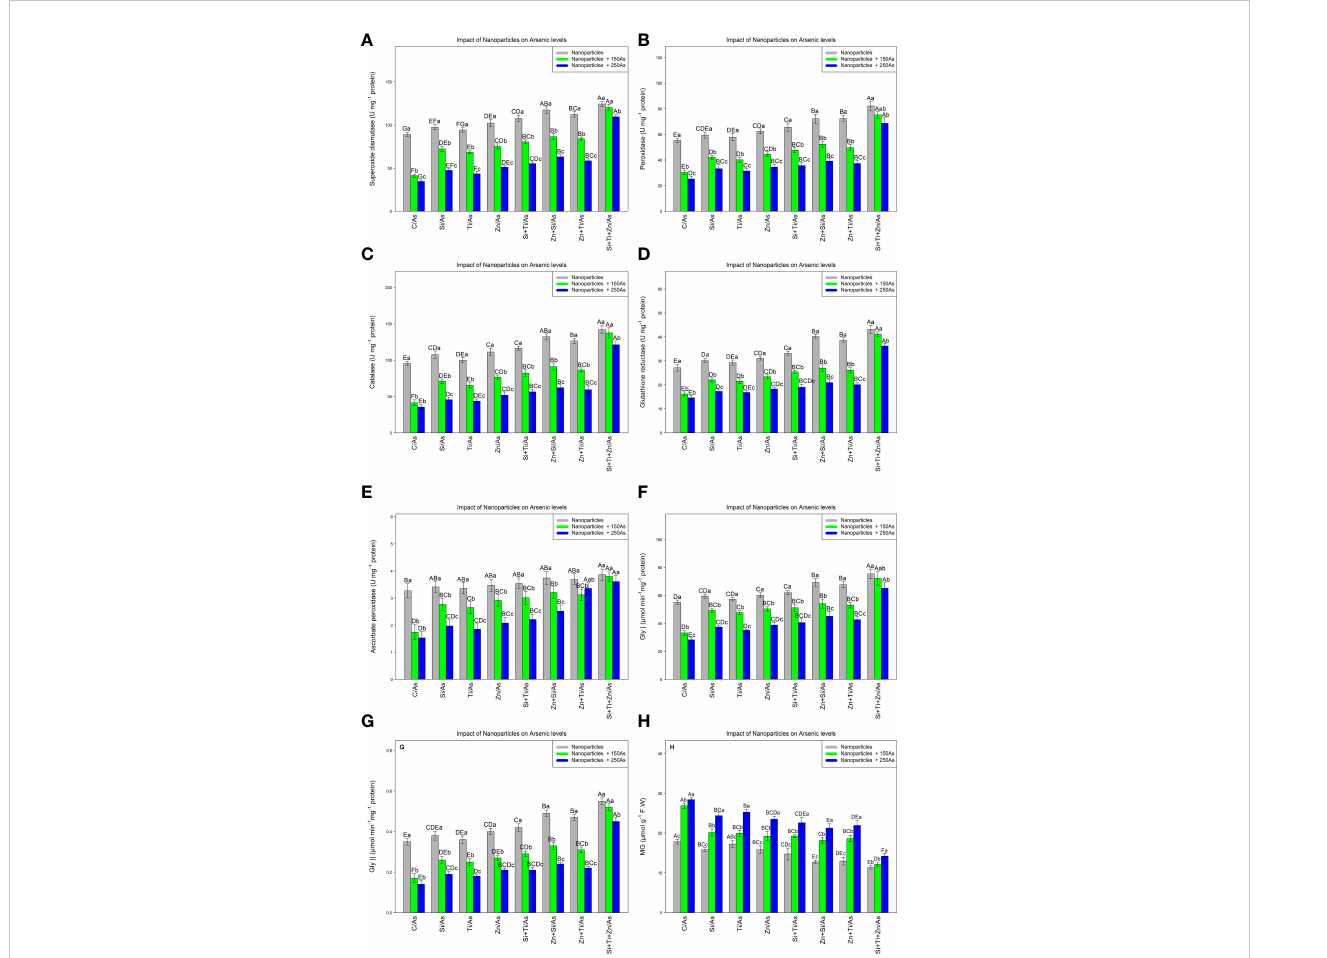
FIGURE 4 The impact of NPs alone and in combination on superoxide dismutase (SOD) (A) , peroxidase (POD) (B) , catalase (CAT) (C) , glutathione reductase (GR) (D) , ascorbate peroxidase (APX) (E) , glyoxalase I (F) , glyoxalase II (G) , and MG (H) in one-year-old Pleioblastus pygmaeus exposed to 150 and 250 µM As (four replicates). In this fi gure, the letters a, b, c, etc. indicated signi fi cant differences following the application of NPs with 150 and 250 µM As based on Tukey ′ s test (p<